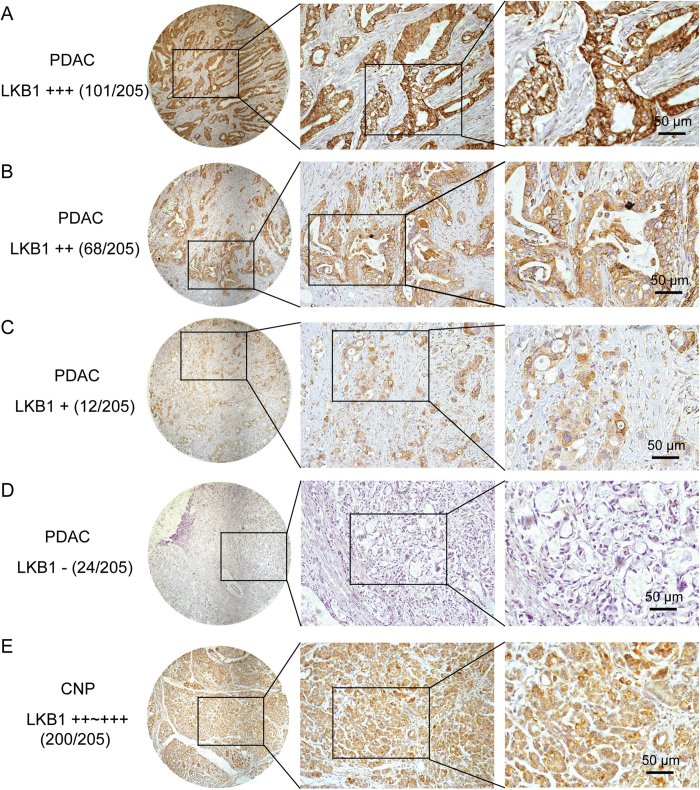
LKB1 expression in PDAC tissue samples. A-E, Representative images of LKB1 expression in PDAC compared with corresponding noncancerous pancreas (CNP); (A) PDAC, scored as (+++); (B) PDAC, scored as (++); (C) PDAC, scored as (+); (D) PDAC, scored as (-); (E) CNP, scored as (++~+++).